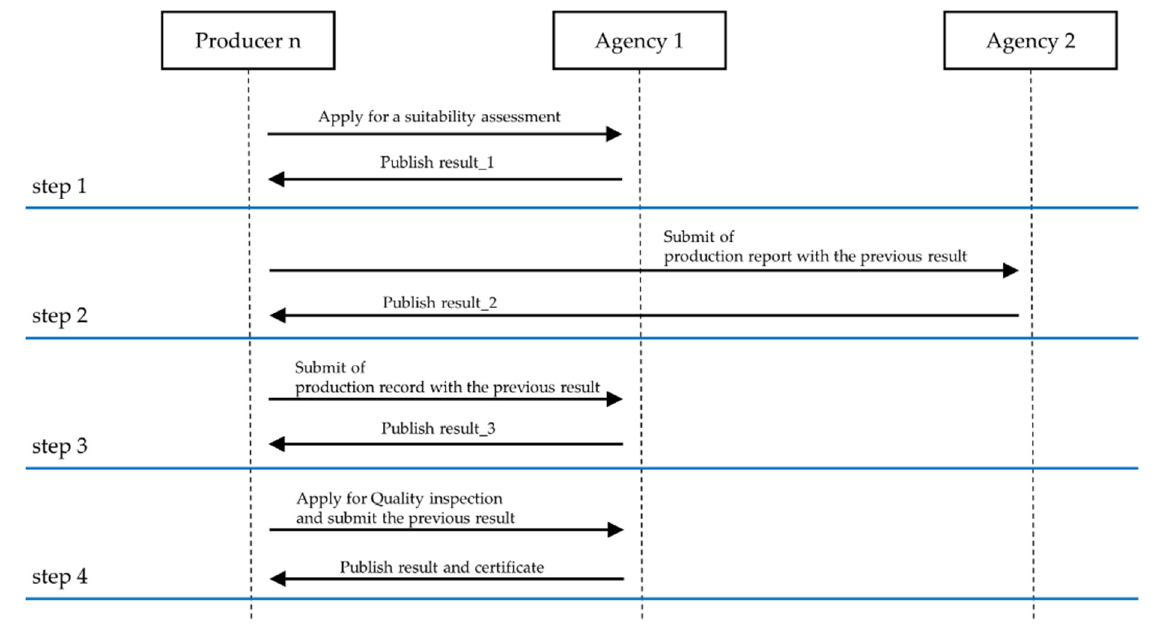
Figure 6. Wild-simulated ginseng quality management process sequence diagram.